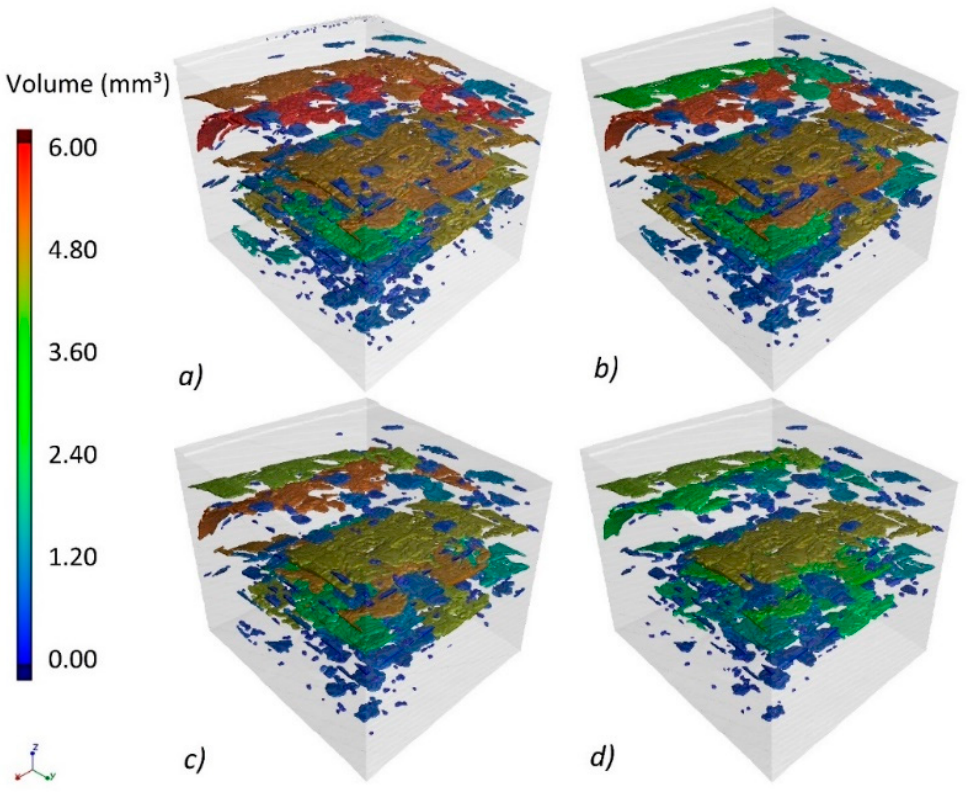
Figure 8. Change in the recorded volume for the reconstruction of the PP composite with different voltages of the X-ray tube, ( a )50 kV, ( b )100 kV, ( c )150 kV, ( d ) 200 kV.